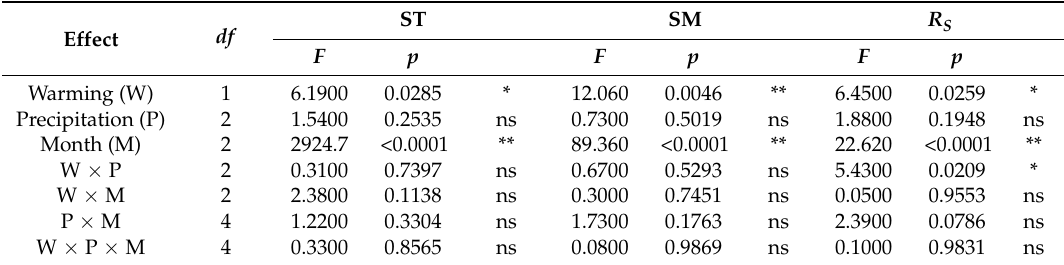
Table 1. Repeated-measure ANOVAs for soil temperature (ST), soil moisture (SM), and soil respiration ( R S ) in response to warming, precipitation manipulation, and their interaction.